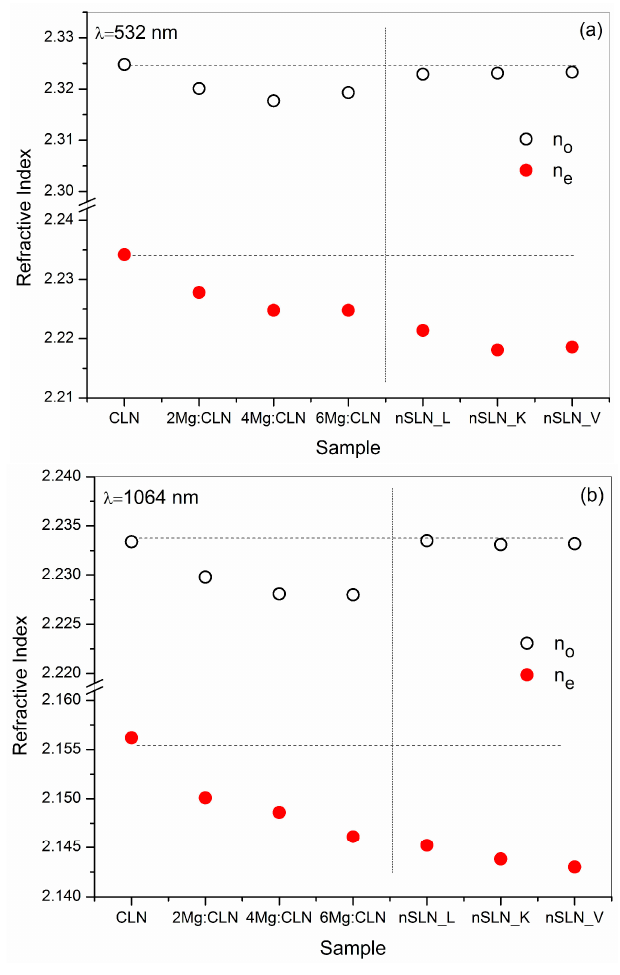
Figure 11. Refractive index ( n o and n e ) of different ( a ) Mg:CLN; and ( b ) nSLN crystals at 532 and 1064 nm wavelength.